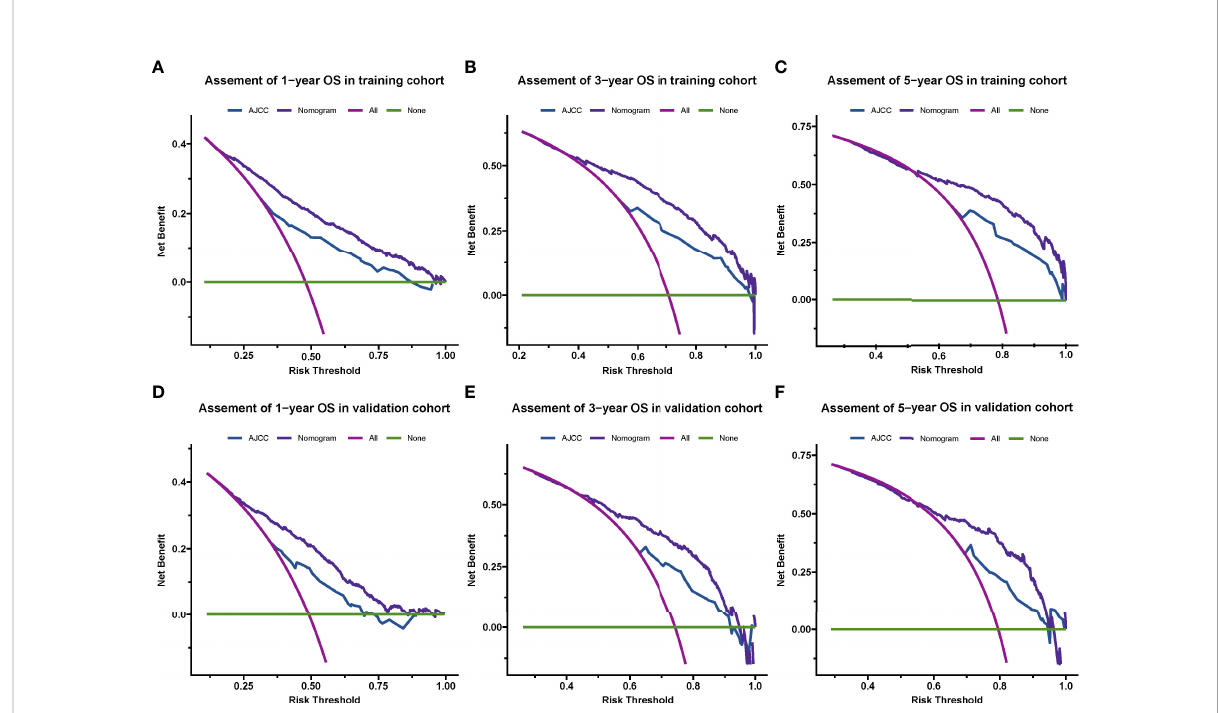
FIGURE 5 Decision curve analysis for the nomogram and AJCC stage in the training cohort (A – C) and validation cohort (D – F) at 1-year, 3-year, and 5- year,